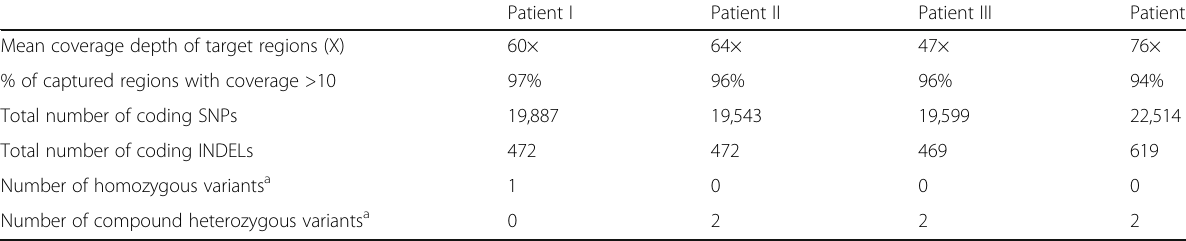
Table 3 Summary of exome sequencing data of the patients from each family